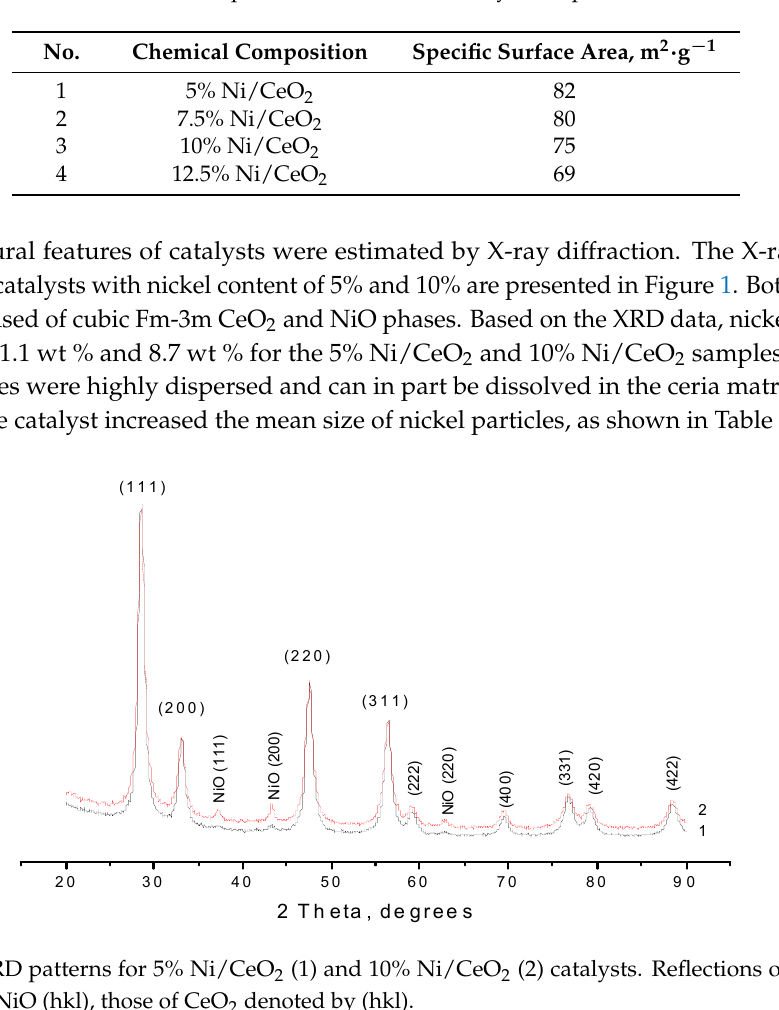
Table 1. Specific surface area of catalyst samples.